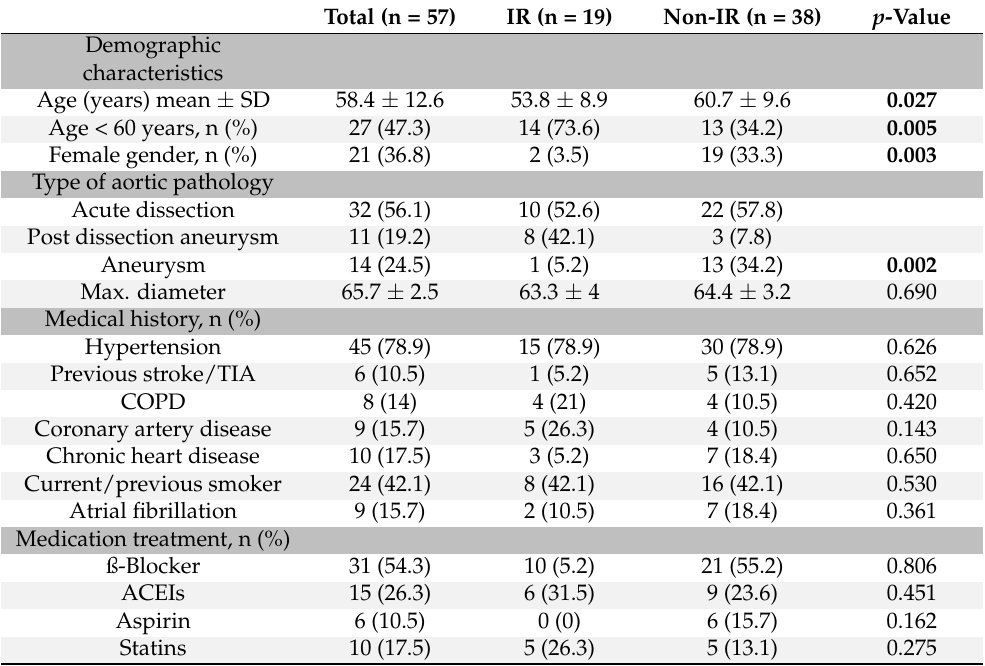
Table 1. Baseline characteristics, comorbidity and medication treatment at admission of the study population divided according to the presence of IR.